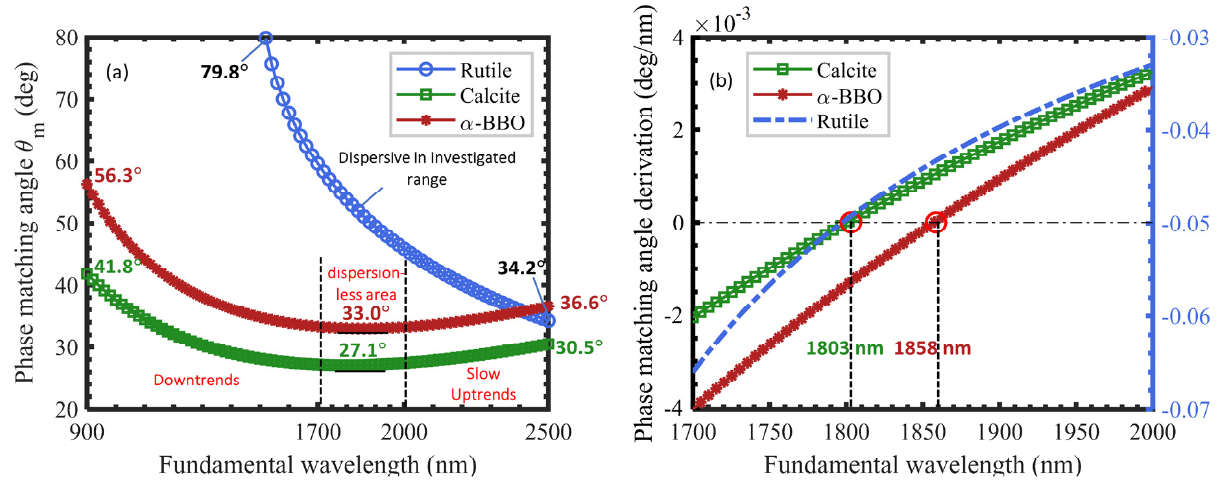
Figure 6. ( a ) The calculated results of phase-matching angle θ m dispersion from 900 nm to 2500 nm; ( b ) The phase-matching angle derivative in the dispersion-less area from 1700 nm to 2000 nm. To evaluate the angle measurement sensitivity of the intensity-dependent method, we calculate the angle dependence of I THW ( θ i ). In the simulation process, the parameters are set as: the focal length f = 70 mm, the Z positions of the crystal are Z L = − 1 mm and Z R = 1 mm, respectively, the crystal length L = Z R − Z L = 2 mm, the diameter of incident femtosecond beam d = 3.6 mm. We assume the focused point (beam waist) is perfectly in the center of the crystal, and the azimuthal angle ϕ = 30 ◦ . The wavelength range of the incident femtosecond laser is set from 1800 nm to 1900 nm, covering the dispersion-less area. The space between the modes is 1 nm. Figure 7 shows the simulated results, where the index (a), (b), and (c) of subplots correspond to α -BBO, calcite, and rutile, respectively. In each subplot, the lines in different colors correspond to the angle dependence I 3 ( θ i ) of different modes or the total intensity I THW ( θ i ). The horizontal axis denotes the angular displacement of the incident angle θ i . The left and right vertical axes denote the intensity of I 3 and I THW , respectively. It is clear that I 3 ( θ i ) does not have an obvious change between the wavelength of 1800 nm, 1850 nm, and 1900 nm for α -BBO and calcite, and the angle dependence of I THW ( θ i ) keeps the same shape as I 3 ( θ i ). The maximum total intensities of I THW are strengthened to 96.8 a.u. ( α -BBO), 93.0 a.u. (calcite), respectively. Conversely,